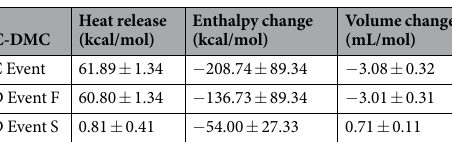
Table 1. The data of thermal and volume change obtained from PAC and PBD. F and S denote the fast and the slow events,